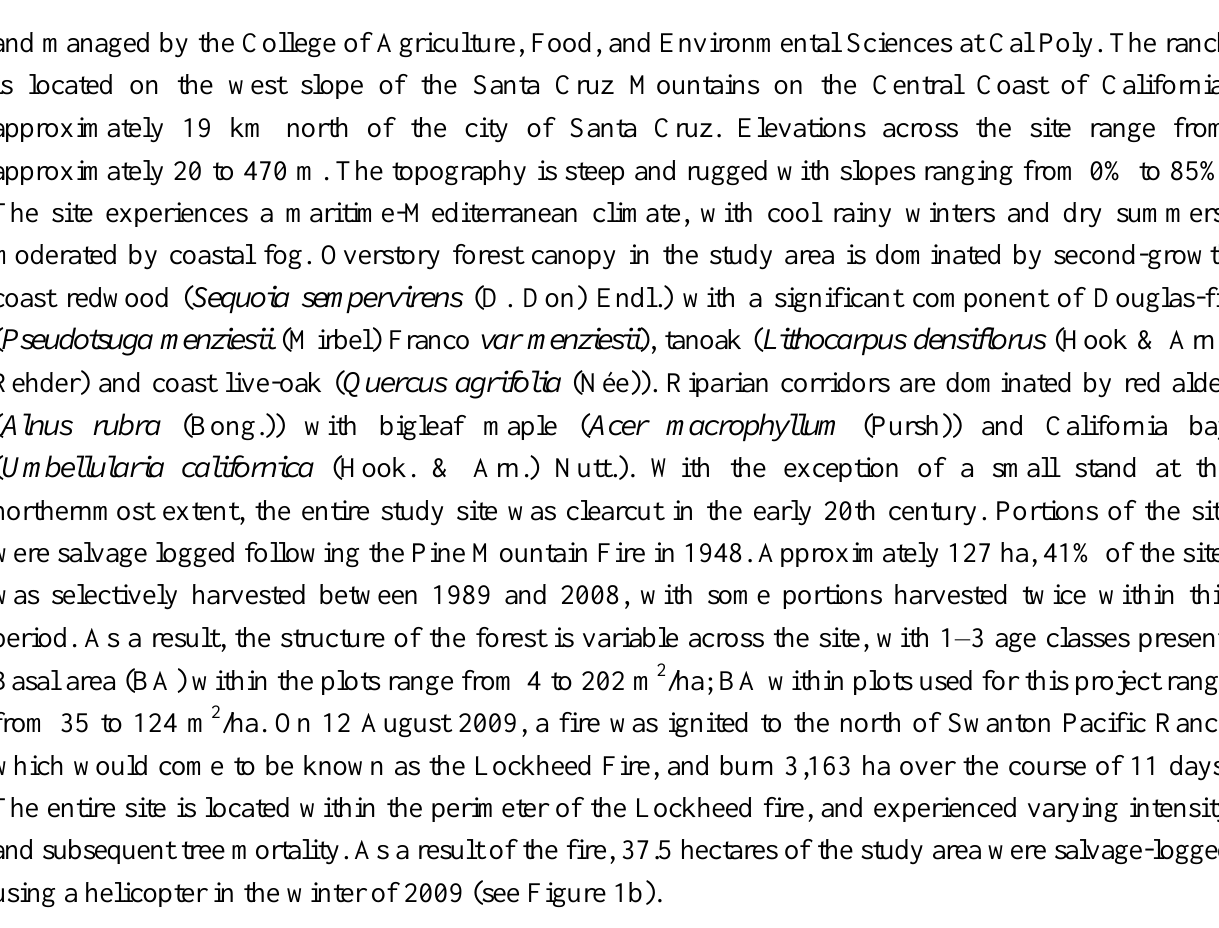
Figure 1. Harvest history within the study area ( a ) regular commercial harvest; ( b ) salvage harvest in